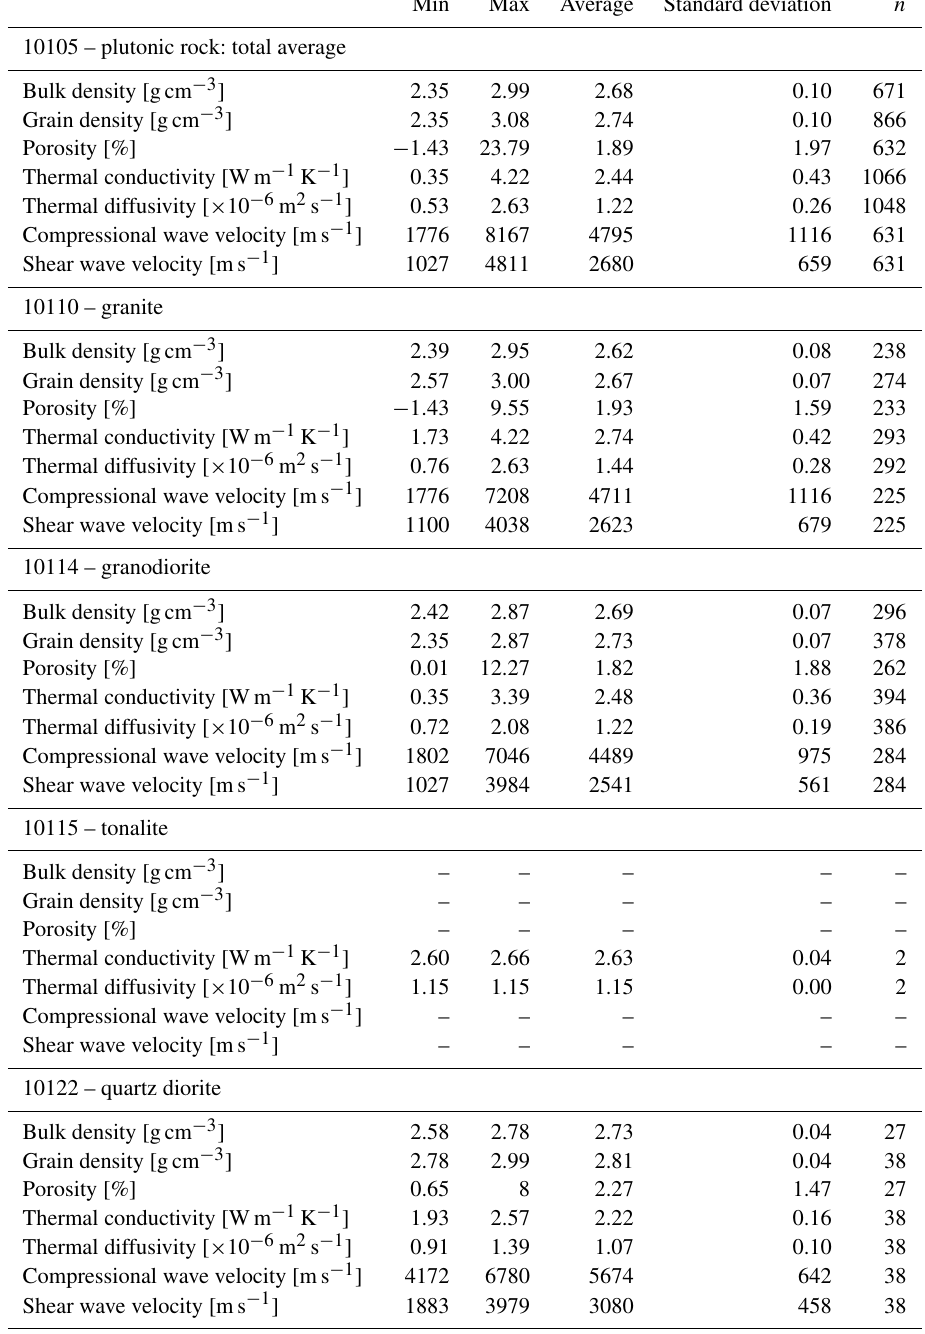
Table 4. Petrophysical properties averaged over the measured samples for each petrographic ID given in the database of Weinert et al.